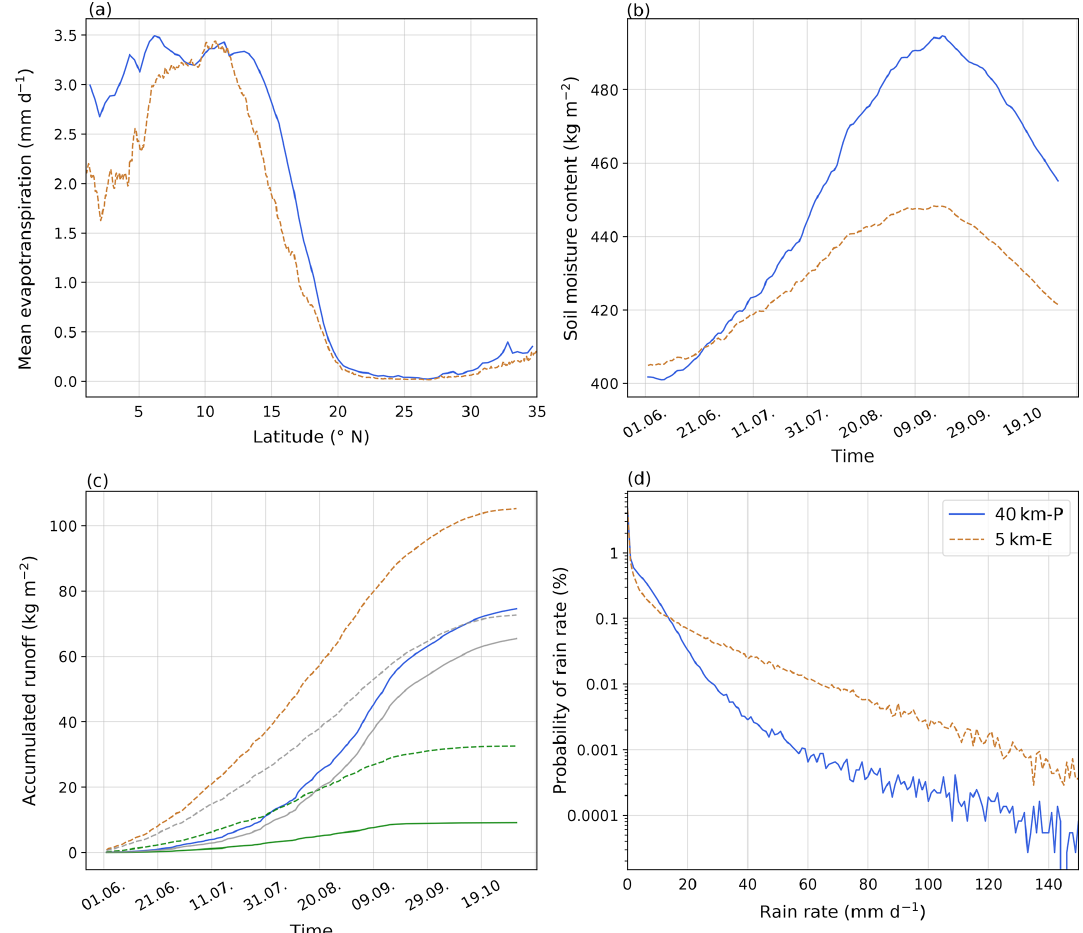
Figure 10. (a) JAS mean meridional distribution of evaporation (b) time series of soil water content: sum over the first six layers (1.62m), (c) JJASO time series of accumulated runoff, surface runoff (green lines) and groundwater runoff (gray lines), (d) probability density function (PDF) of JAS mean rain rate for the 40km-P (solid blue) and the 5km-E (dashed orange) simulation excluding days with rain rates equal to 0mmd − 1 . All calculations are performed over land of the dashed “WA domain” outlined in Fig.